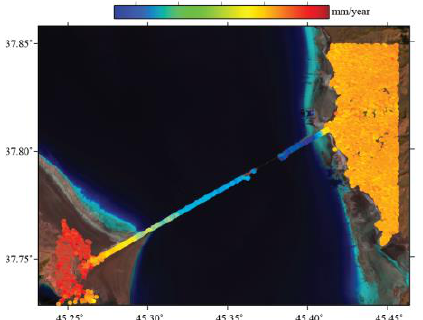
Figure 2. LOS deformation velocity map derived from ENVISAT (Track 321) in the time period of 2003-2007.